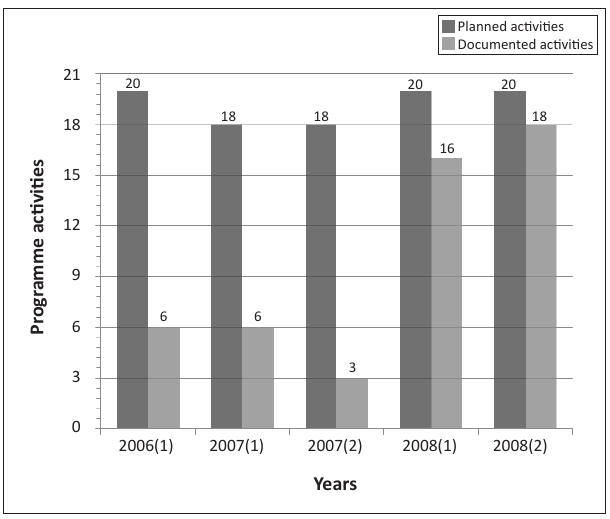
FIGURE 3: Number of planned and documented programme activities from 2006 to